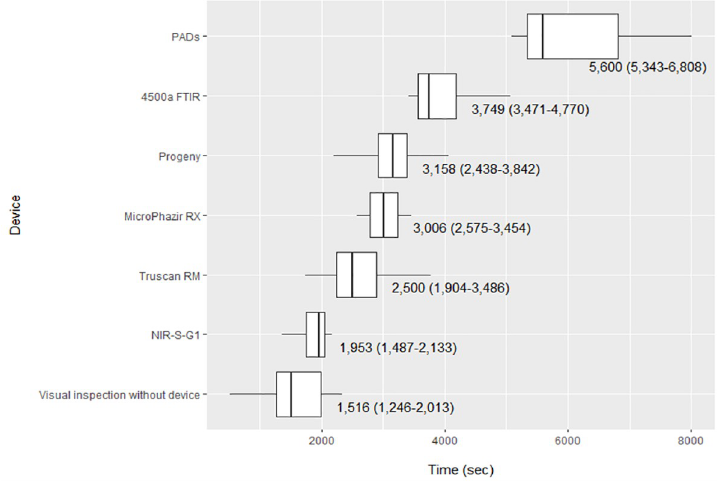
Fig 2. Time spent inspecting evaluation pharmacy, by device. Values in the figure are medians (IQR); 2,000 seconds is ~ 33 minutes and 8,000 seconds is about 2 hours.